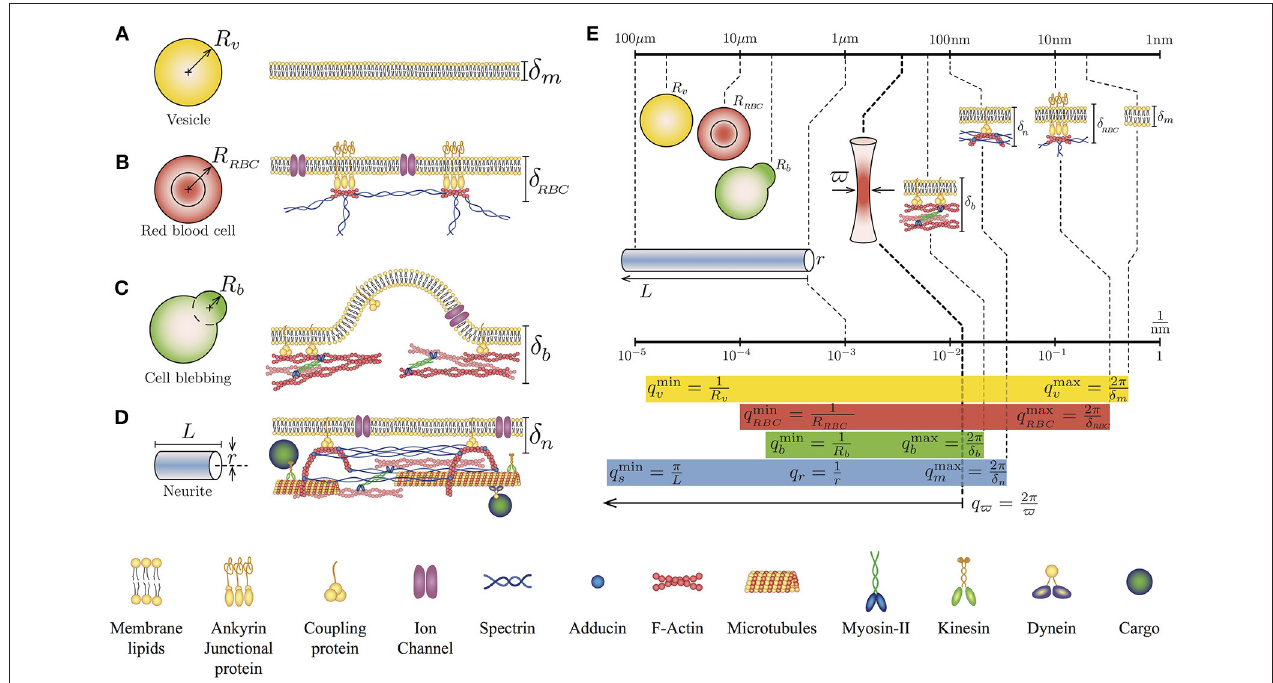
FIGURE 1 | Geometry and simplified cytoskeletal architecture of (A) Giant Unilamellar Vesicle of radius R v and lipid membrane thickness δ m , (B) Human red blood cell of radius R RBC and membrane thickness δ RBC , (C) Bleb of a blebbing-based motility cell R b and membrane thickness δ b , and (D) Neurite of length L radius r and membrane thickness δ n . Note that the membrane thickness δ is referred to the plasma membrane-cytoskeleton thickness. (E) Comparison of the lengths scales and q wave-vectors for the different cell types and cytoskeletal architecture in relation to the waist size of the laser spot ̟ . The q values for each case correspond to the theoretical integration limits of Equations (1) and